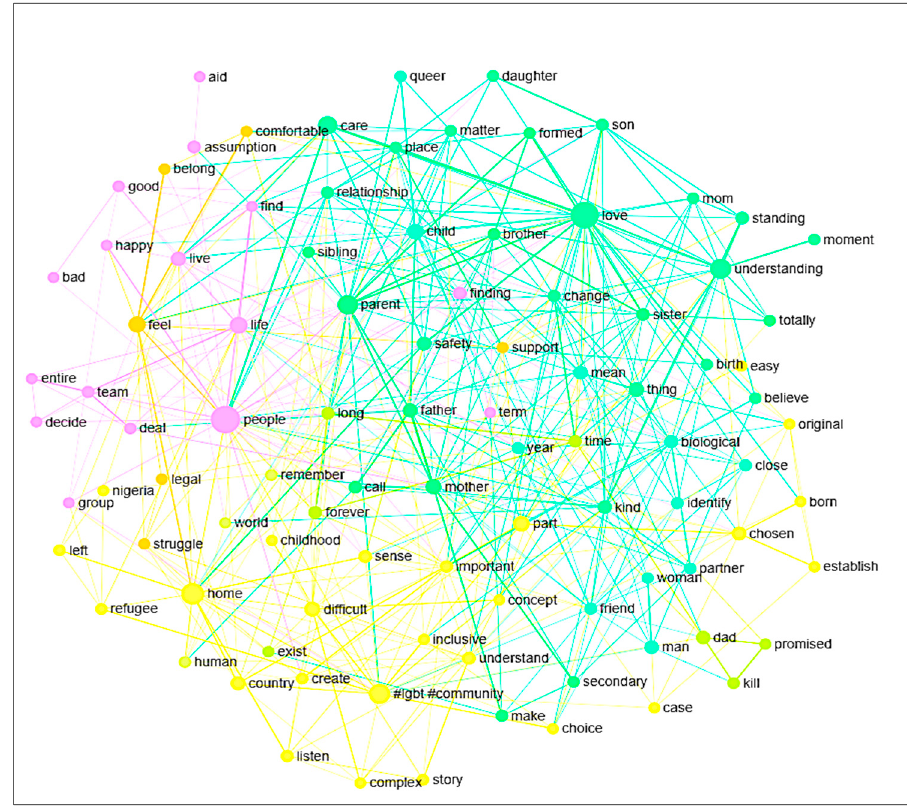
Figure 1 . Concept graph. Figure 1. Concept